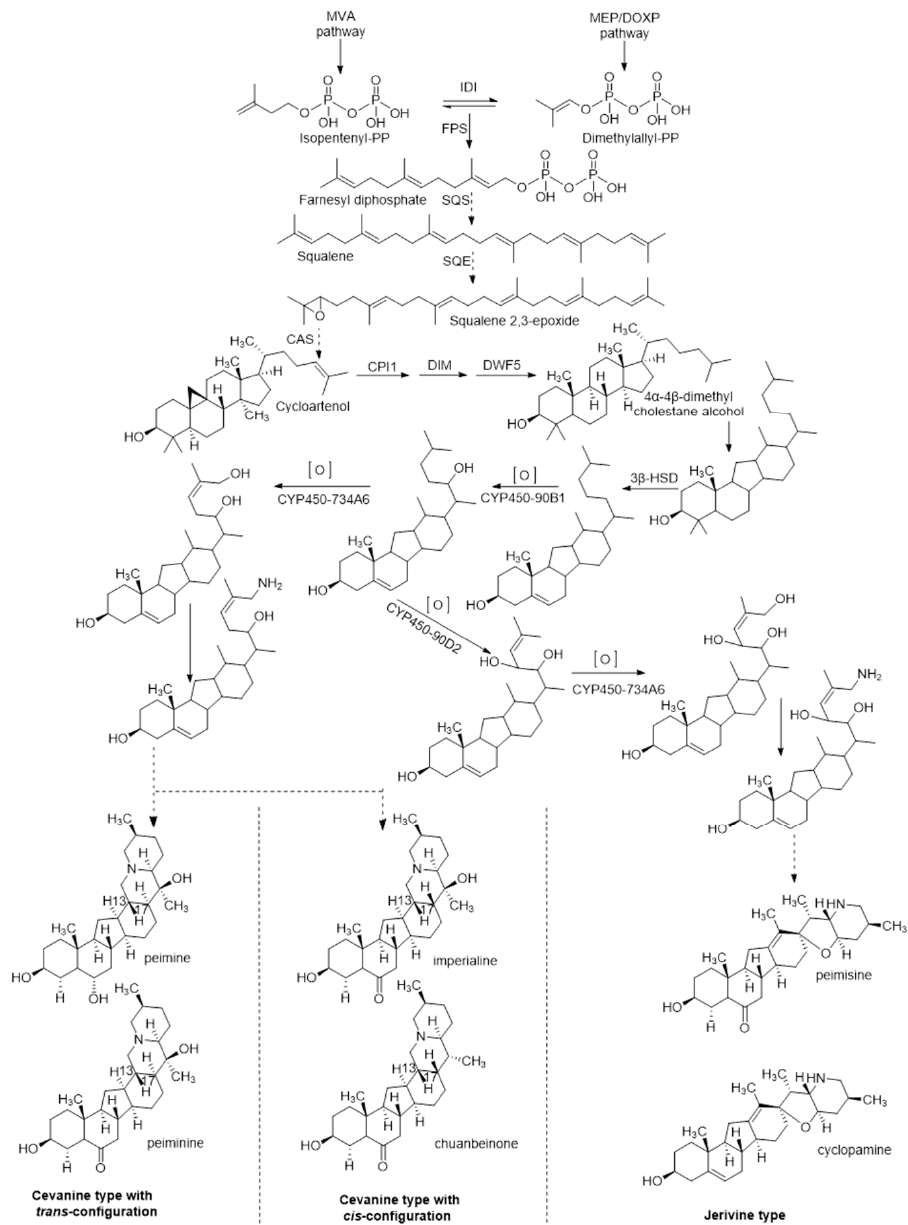
Figure 2. The biosynthetic pathways of Cevanine and Jervine types isosteroidal alkaloids in Fritillaria species. Peimine and peiminine are the Cevanine type alkaloids with trans -configuration. Imperialine and chuanbeinone are the Cevanine type alkaloids with cis -configuration. Peimisine and cyclopamine are the Jervine type alkaloids. IDI: Isopentenyl diphosphate isomerase; FPS: farnesyl diphosphate synthase; SQS: squalene synthase; SQE: squalene oxidase; CAS: cycloartenol synthase; CPI1: cyclo- propyl sterol isomerase1; DIM: delta (24)-sterol reductase; DWF5: 7-dehydrocholesterol reductase; 3 β -HSD: 3 β -hydroxysteroid decarboxylase; CYP450-90B1: C-22